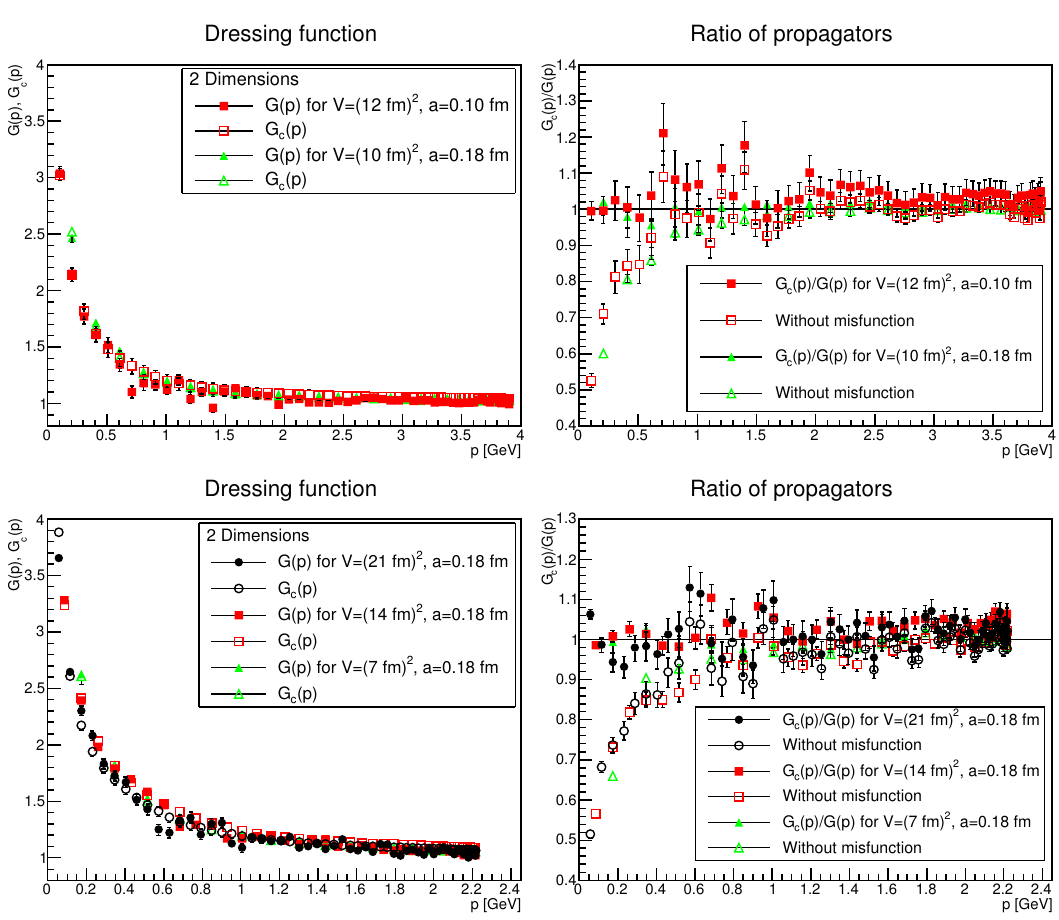
Figure 1: The dressing function in comparison to the DSE result in two dimensions. The left-hand side compares the measured ghost dressing function to the one ob- tained from (5), i. e. when including the misfunction. The right-hand side shows the ratio of the measured ghost propagator to the calculated one from (5), i. e. with the fitted misfunction, and once without, i. e. f = 0. The top panels compare results at different discretizations for roughly fixed physical volume, while the bottom panel compare results at fixed discretizations and different physical